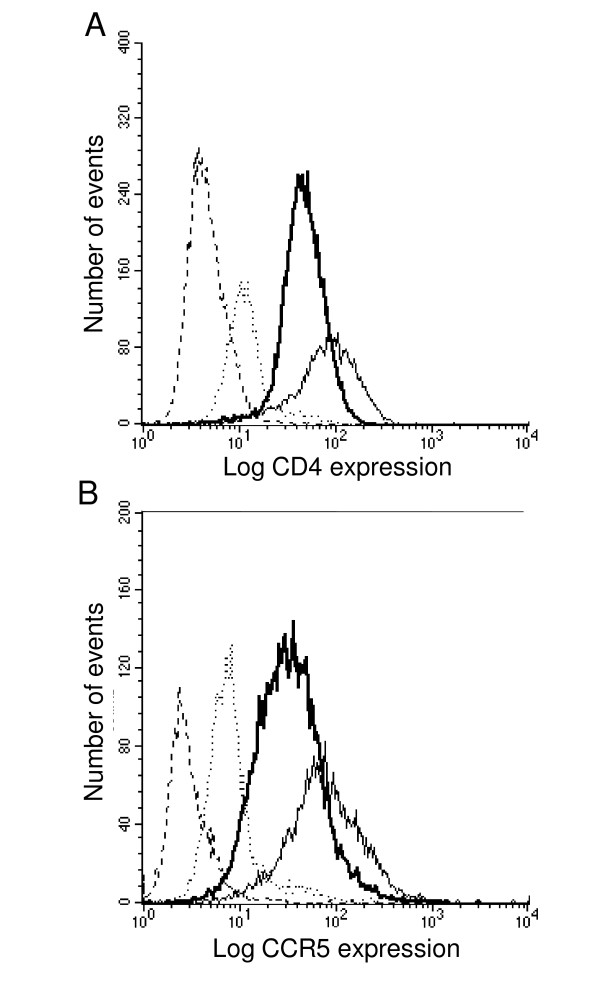
Expression of CD4 and CCR5 on U373-R5 cells and MT4-R5 cells. Cells were resuspended in PBS containing 20% human serum and incubated with directly-conjugated monoclonal antibodies or isotype-matched control antibodies conjugated with the same flurochrome. (A) CD4 expression on U373-R5 cells (thin solid line) and MT4-R5 cells (heavy solid line) detected using FITC-labelled mouse anti-human CD4 monoclonal antibody (clone RPA-T4). Binding of an isotype-matched control antibody conjugated with FITC is shown in the corresponding dashed lines. (B) CCR5 expression on U373-R5 cells (thin solid line) and MT4-R5 cells (heavy solid line) detected using phycoerythrin-conjugated mouse anti-human CCR5 monoclonal antibody (clone 2D7). Binding of an isotype-matched control antibody conjugated with phycoerythrin to these cells is shown in the corresponding dashed lines.